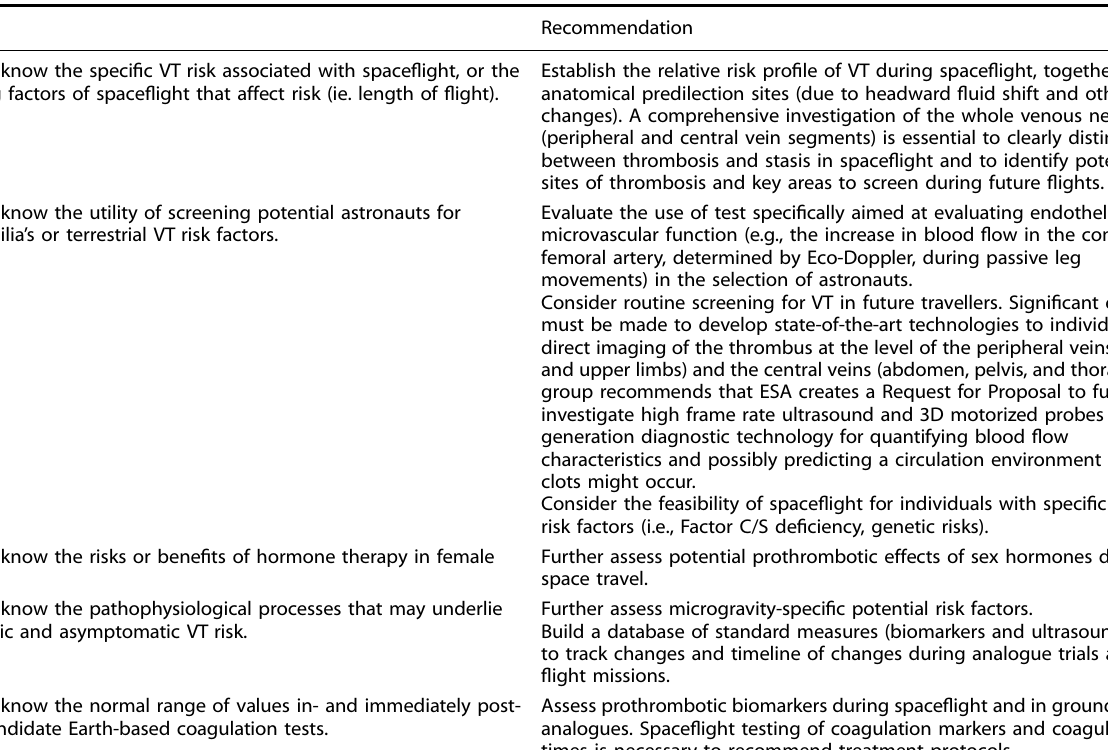
Table 2. Pathophysiology/Risk — Gap Analysis and